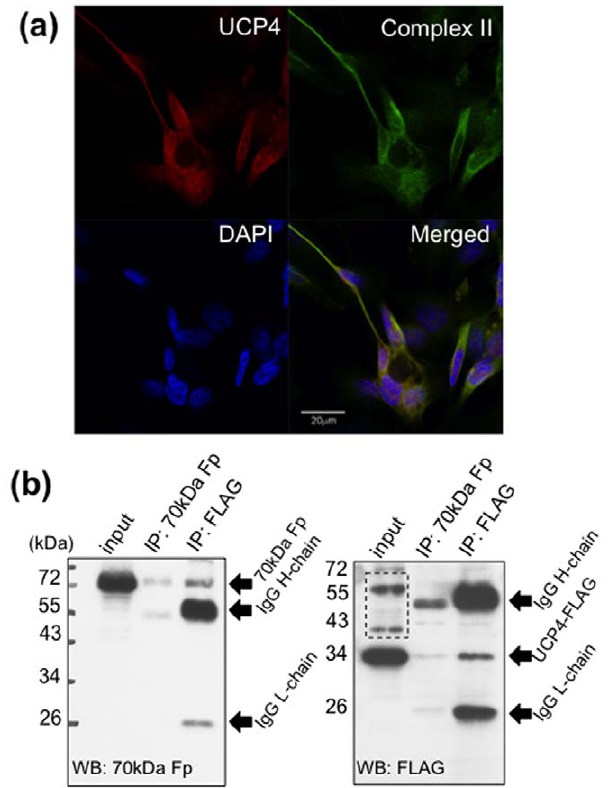
Figure 6. Immunocytochemistry and co-immunoprecipitation of UCP4 and mitochondrial Complex II in UCP4-overexpressing SH-SY5Y cells. (a) UCP4 (red) and a 70 kDa Complex II subunit, Fp (green), were co-localized in mitochondria. (b) Co-immunoprecipitation and western blots of recombinant UCP4 protein and Complex II subunit, Fp. Mitochondrial lysates from UCP4-overexpressing cells were immunoadsorbed (IP) with either anti-FLAG or anti-70 kDa Fp, antibody separately. The resultant antibody-protein pull-down lysates were further adsorbed by Protein-G-sepharose beads. The adsorbed proteins were cross-detected using anti-FLAG and anti-70 kDa Fp in western blots. The pull-down lysate from anti-FLAG showed a band at 70 kDa detected by anti-70 kDa Fp; and the pull-down lysate from anti-70 kDa Fp showed a band at 34 kDa detected by anti-FLAG. IgG-heavy chain and IgG-light chain were detected at , 55 kDa and , 25 kDa, respectively. Dashed box showed non-specific bands from crude mitochondrial lysate detected by anti-FLAG.